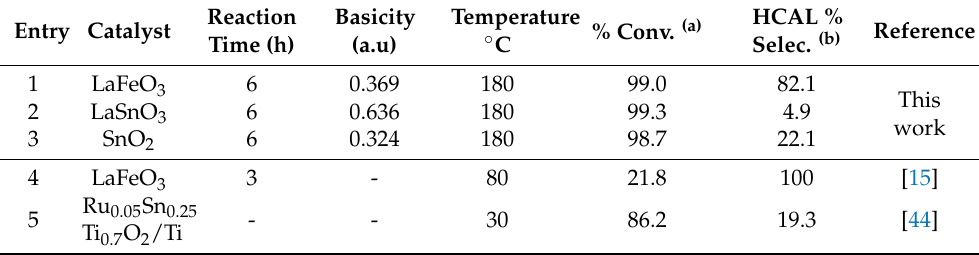
Table 2. A catalyst comparison study of the prepared perovskites with previously reported